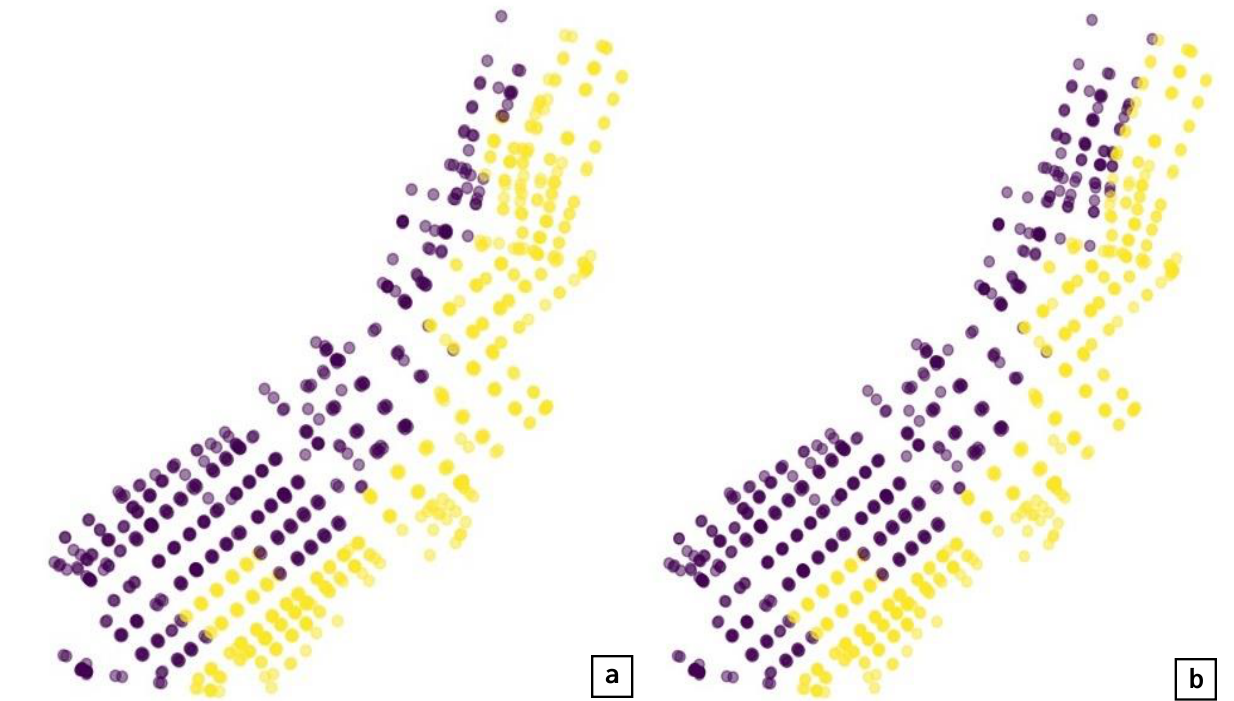
Figure 3. Partitioning of PMA “Kentro” into two clusters based on ( a ) nodal altitudes, and ( b ) simulated pressures.